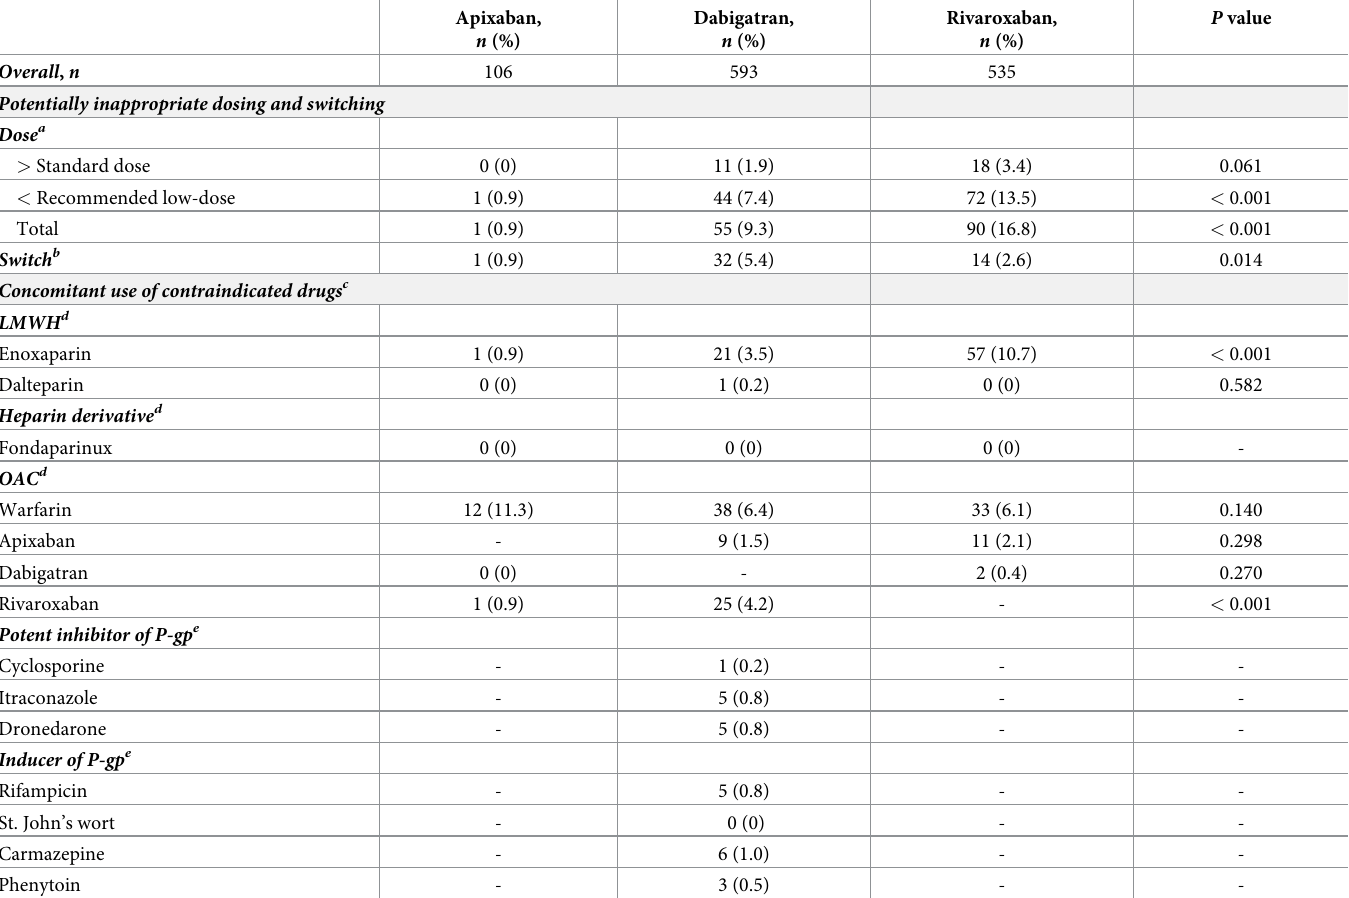
Table 2. Percentage of potentially inappropriate dosing, switching, and concomitant use of contraindicated drugs of direct oral anticoagulants in patients with atrial fibrillation aged over